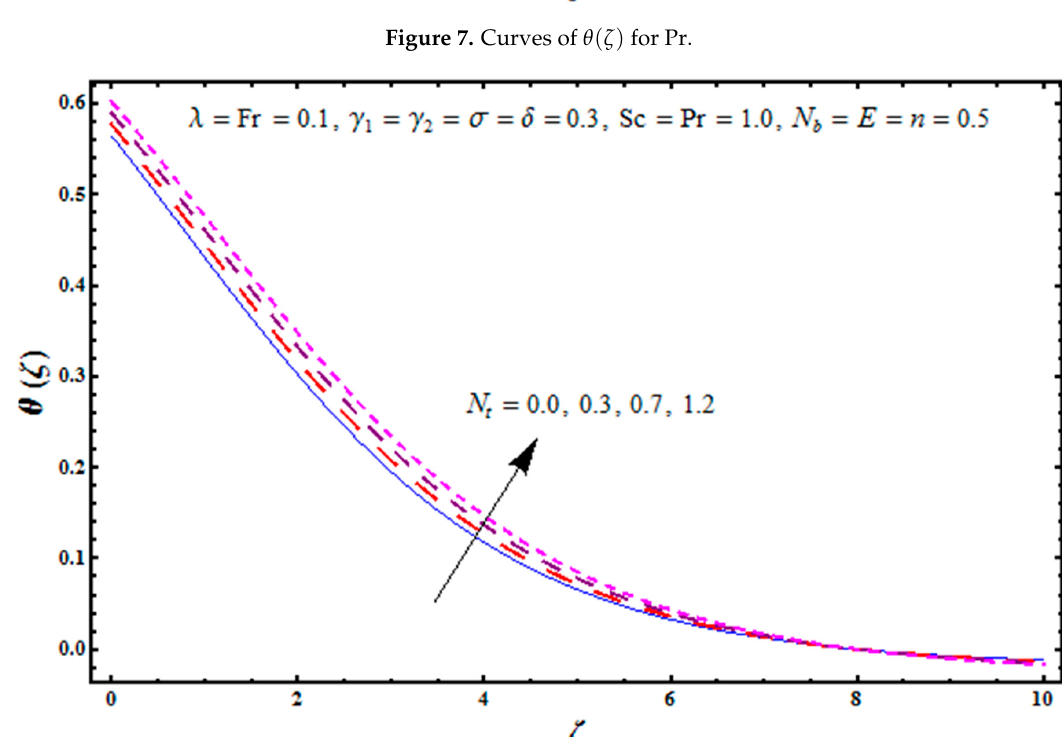
Figure 8. Curves of θ ( ζ ) for N t